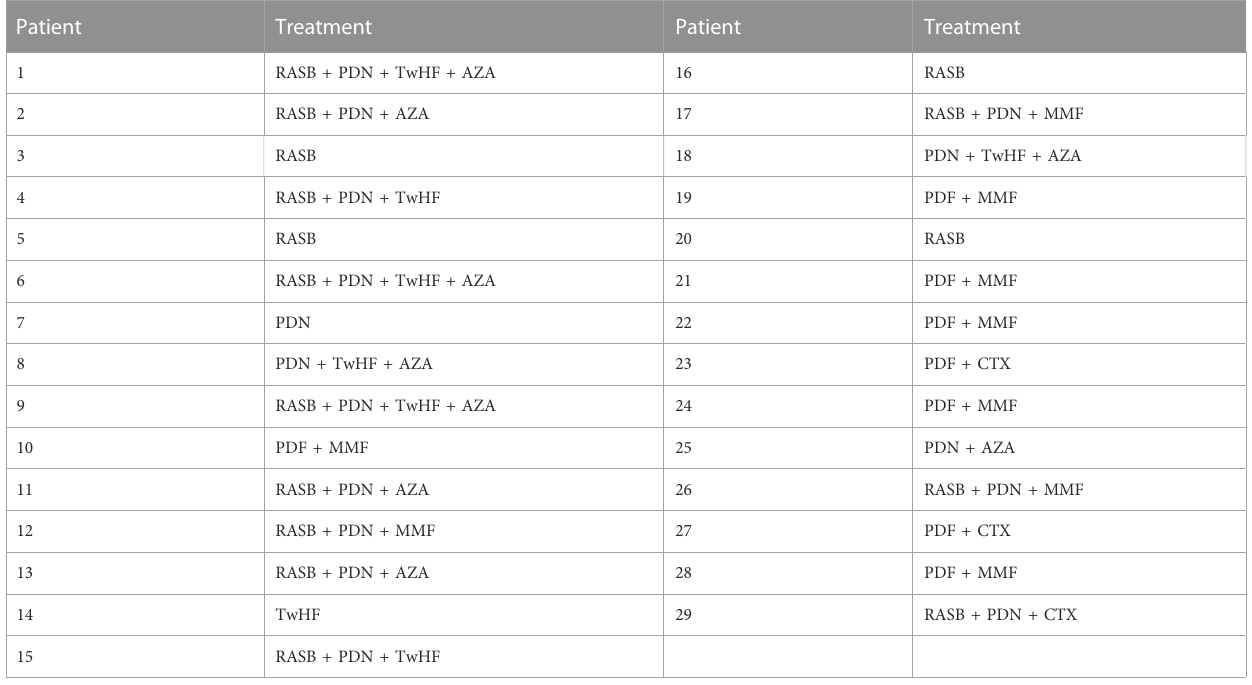
TABLE 2 The treatment of IgA nephropathy patients with isolated hematuria who underwent repeat biopsies ( n = 29). Patient Treatment Patient